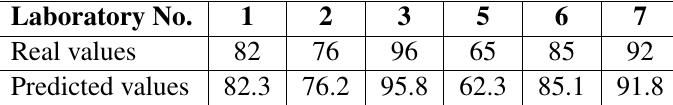
Fig. 2 The structure of the BP neural network. Table 6 Comparison of real values and predicted values.